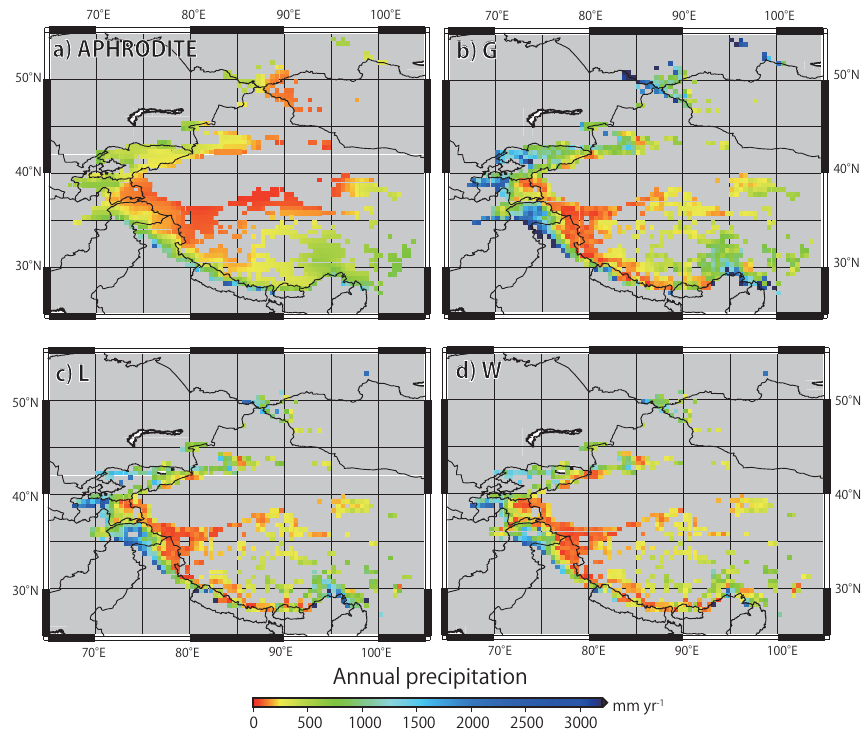
Figure 6. Annual solid and liquid precipitation of APHRODITE averaged from 1979 to 2007 (a) , at which a glacier was located in the GGI. Calculated annual precipitation assumed to accumulate on glacier surfaces based on (b) G-, (c) L-, and (d) W-average